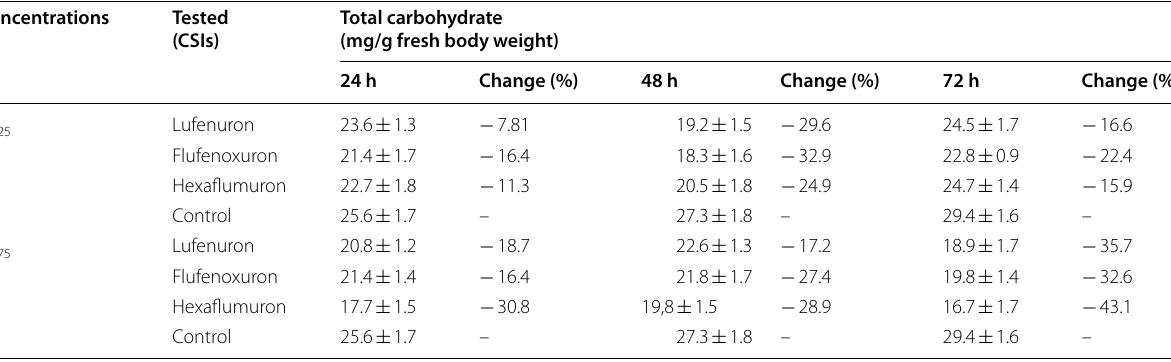
and LC concentrations at different time intervals 25 75